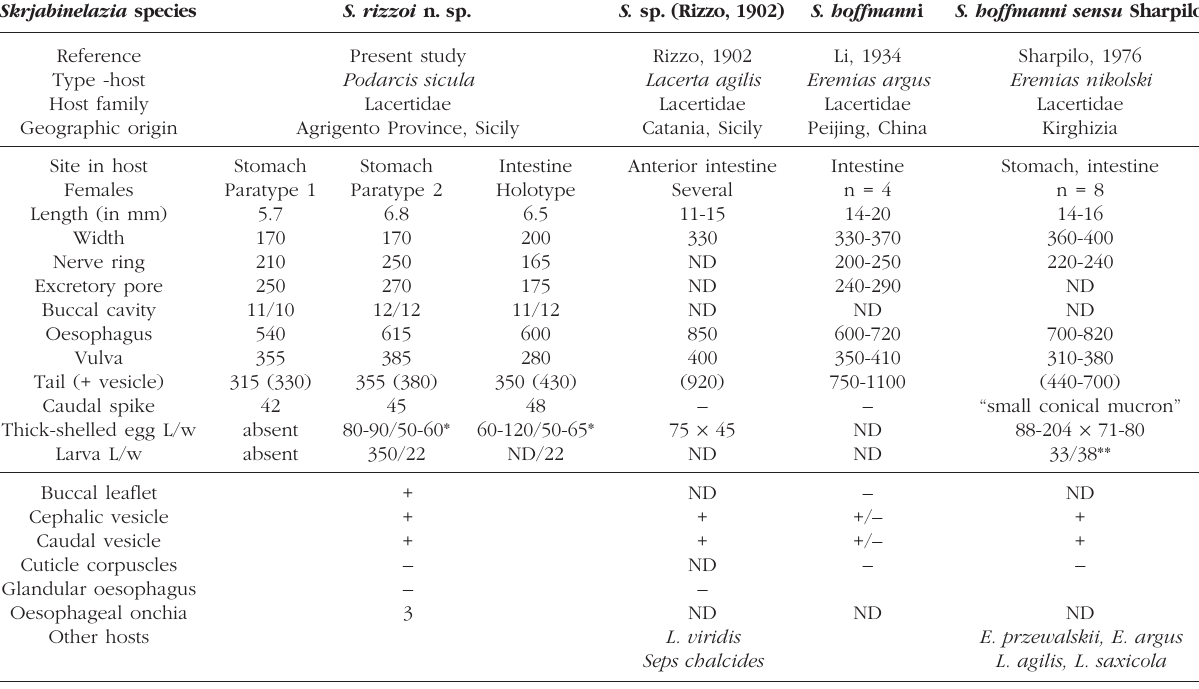
Table I. – Female measurements and main qualitative characters of Skrjabinelazia rizzoi n. sp., Skrjabinelazia sp. Rizzo, 1902, S. hoffmanni Li, 1934 and S. hoffmanni sensu Sharpilo,